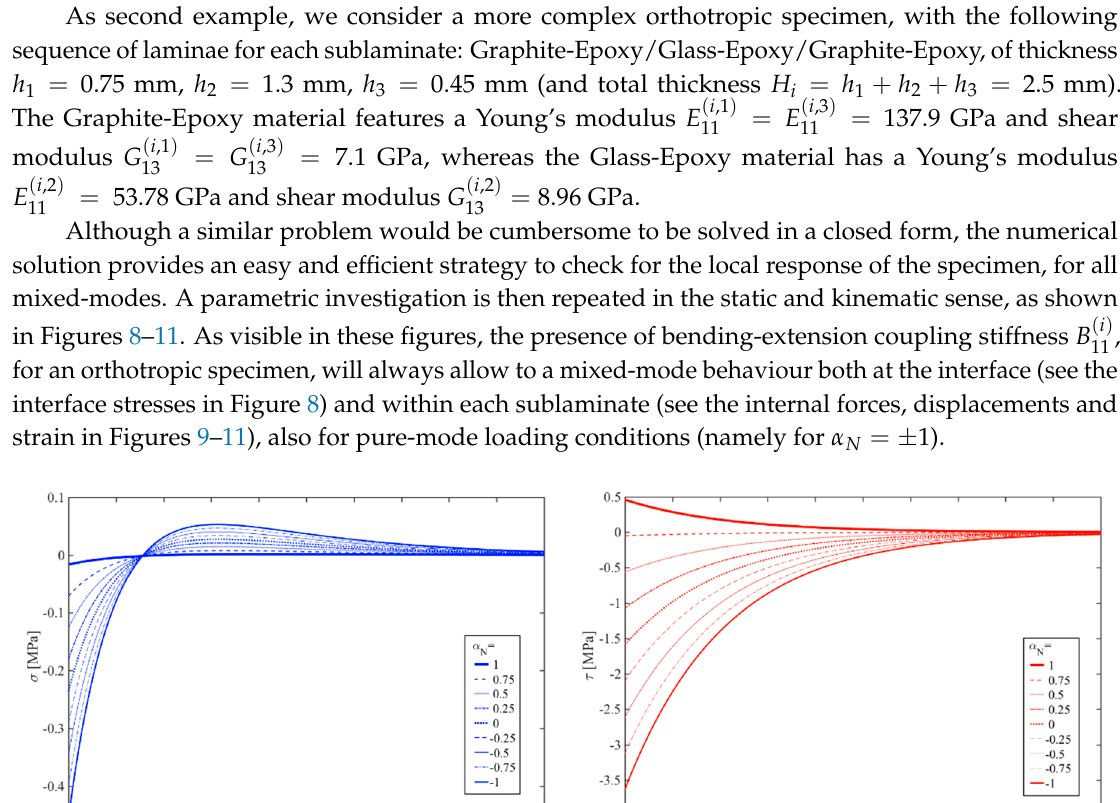
Figure 7. Effect of the axial loading ratio on the ( a ) Mode-mixity angle ψ ; ( b ) Critical energy G cr . (Isotropic specimen).